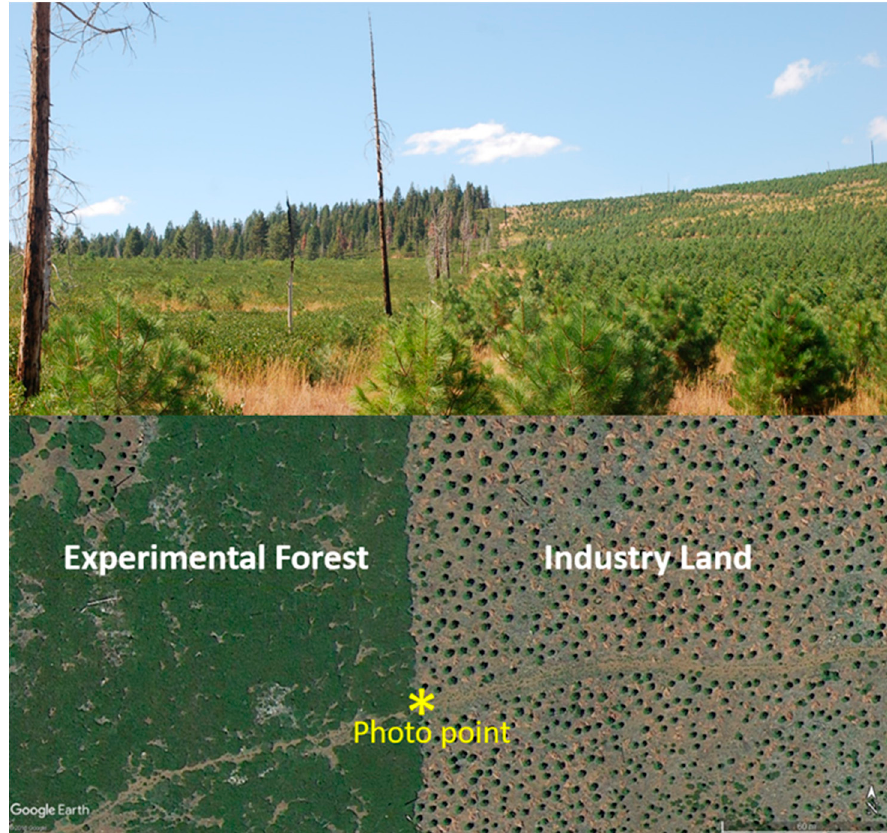
Figure 2. Post-fire regenerated plantations on public land at Blacks Mountain Experiment (left) and on private industry land (right), the latter formerly owned by Roseburg Forest Resources, now Sierra Pacific Industries. Both sides were planted with one-year-old ponderosa pine seedlings in 2005. The upper picture was taken at the photo point (*) prior to the precommercial thinning in 2009. The bottom 2014 image from Google Earth shows the post thinning plantation on industry land.